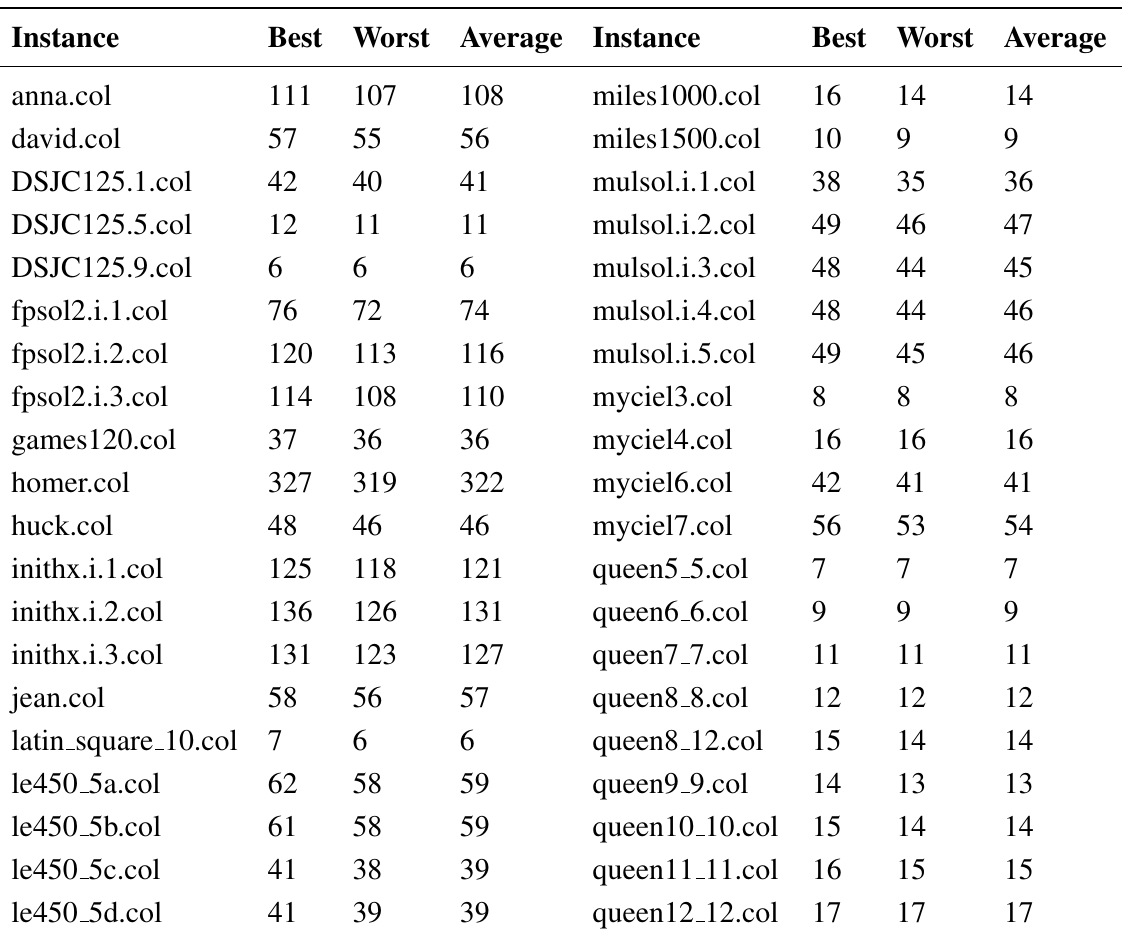
Table 5. Results for variable neighborhood search 1 (VNS1) with k limit of 30 min for 15